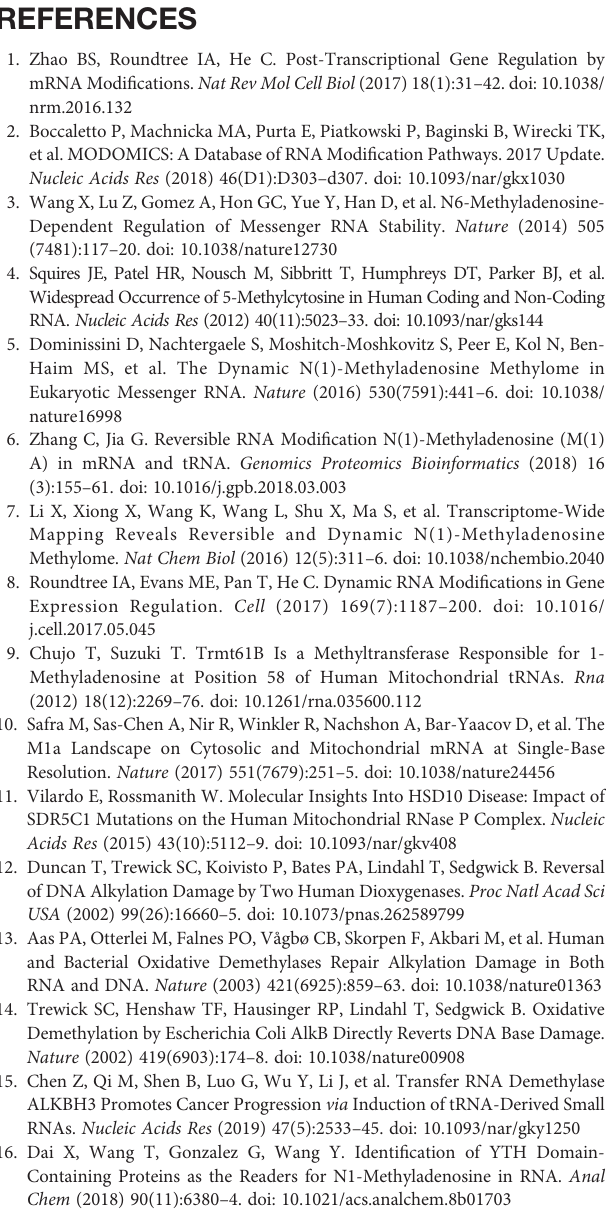
Supplementary Figure 1 | The work fl ow employed in the development of the m1Ascore. Supplementary Figure 2 | The mutation frequency of 10 m1A regulators in 436 patients with ovarian cancer. Each column represented individual patients. The upper barplot showed TMB and the number on the right indicated the mutation frequency in each regulator. Theright barplot showed the proportion of each variant type. The stacked barplot below showed fraction of conversions in each sample. Supplementary Figure 3 | (A) Differential expression of the m1A methylation regulators at the protein level. (B) Kaplan-Meier curves demonstrate the prognostic relevance of m1A methylation regulator expression to OC patients. (A) Supplementary Figure 4 | (A) Cumulative distribution function curves for unsupervised clustering of 10 m1A regulators, k = 2-9. (B) Relative change in area